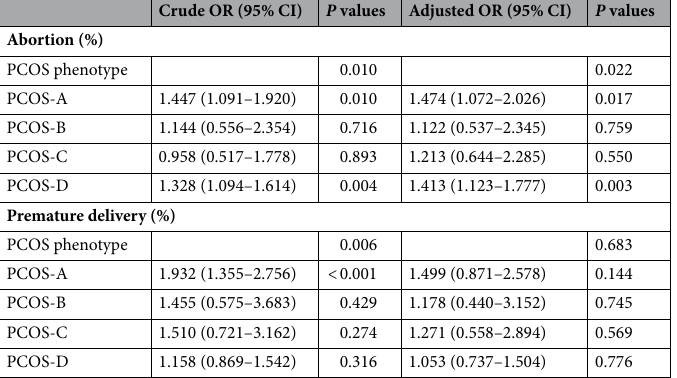
Table 3. Crude and adjusted ORs of various PCOS phenotypes for abortion and premature delivery. CI, confidence interval; OR, odds ratio; PCOS, polycystic ovary